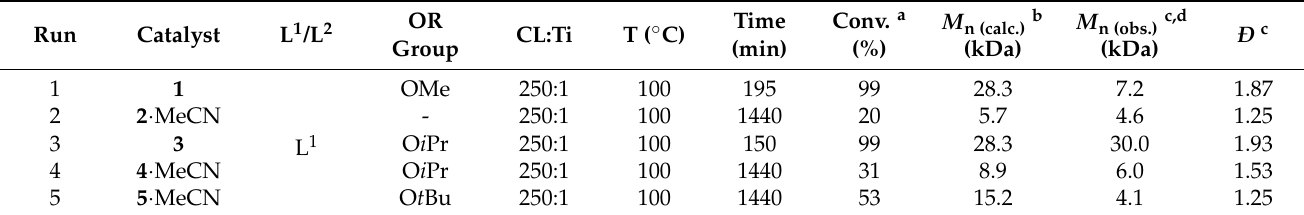
Table 1. ROP of ε - CL catalyzed by the Ti complexes 1 – 10 and [Ti(OR) 4